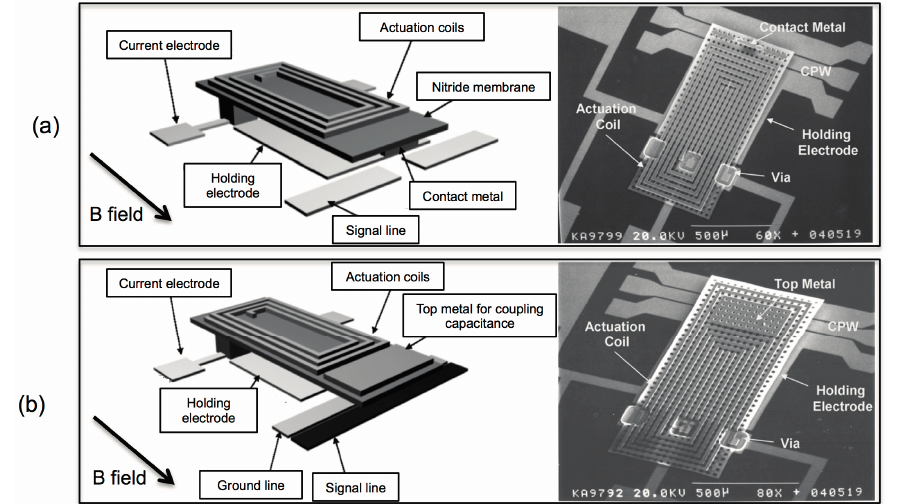
Figure 12. Diagram ( left ) and SEM photograph ( right ) of the ohmic ( a ) and capacitive ( b ) devices proposed by Cho et al . [83]. Reprinted with permission from [83]. Copyright 2005